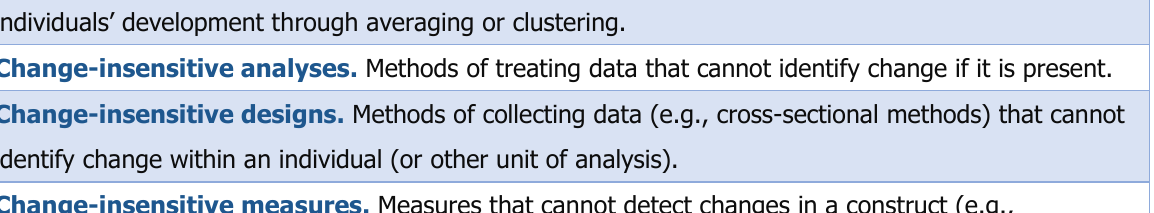
Table 2. Concepts Associated With Change-Sensitive Developmental Methods Aggregation of individuals’ developmental change. Combining information about two or more individuals’ development through averaging or